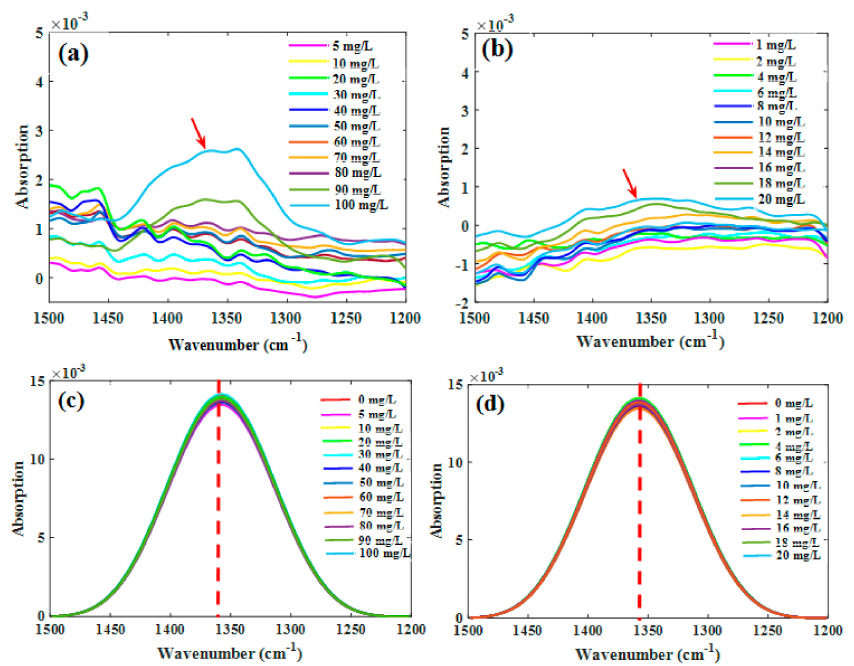
Figure 2. Characteristic absorption bands of nitrate solutions through water deduction (( a ) high-concentration group; ( b ) low-concentration group; n = 44) and deconvolution from raw spectra (( c ) high-concentration group; ( d ) low-concentration group; n =